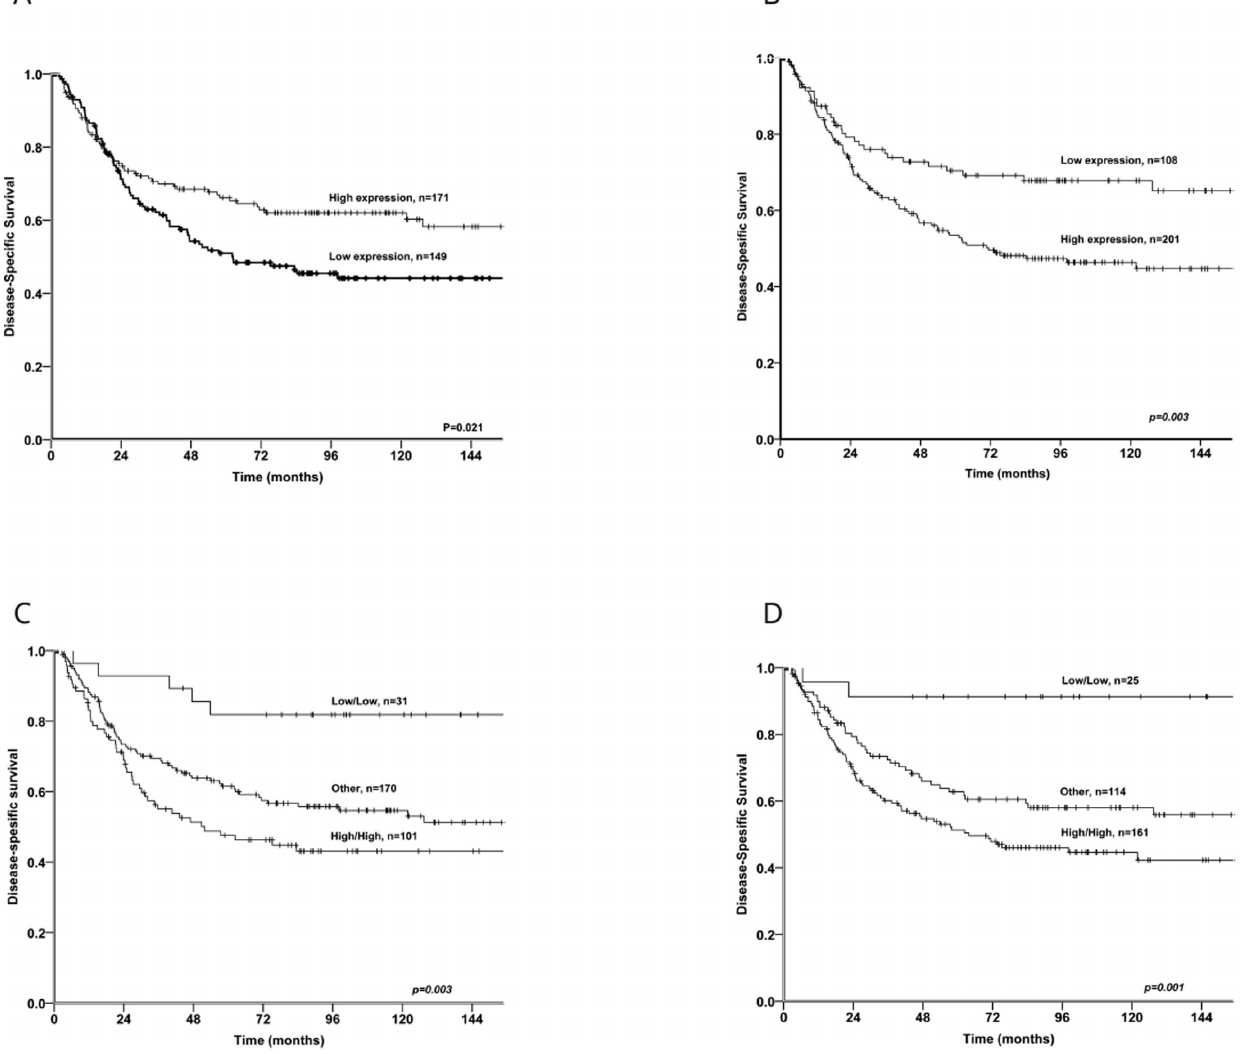
Figure 3. Kaplan Meier curves with DSS for expression of MCT1 and co-expression variables. Kaplan Meier curves with disease-specific survival for expression of monocarboxylate transporter (MCT)1 in cancer cells and stromal cells and the co-expression variable GLUT1c + MCT4c and GLUT1c + MCT1s in NSCLC. A) MCT1 in cancer cells, B) MCT1 in stromal cells, C) GLUT1c + MCT4c, D) GLUT1c + MCT1s.